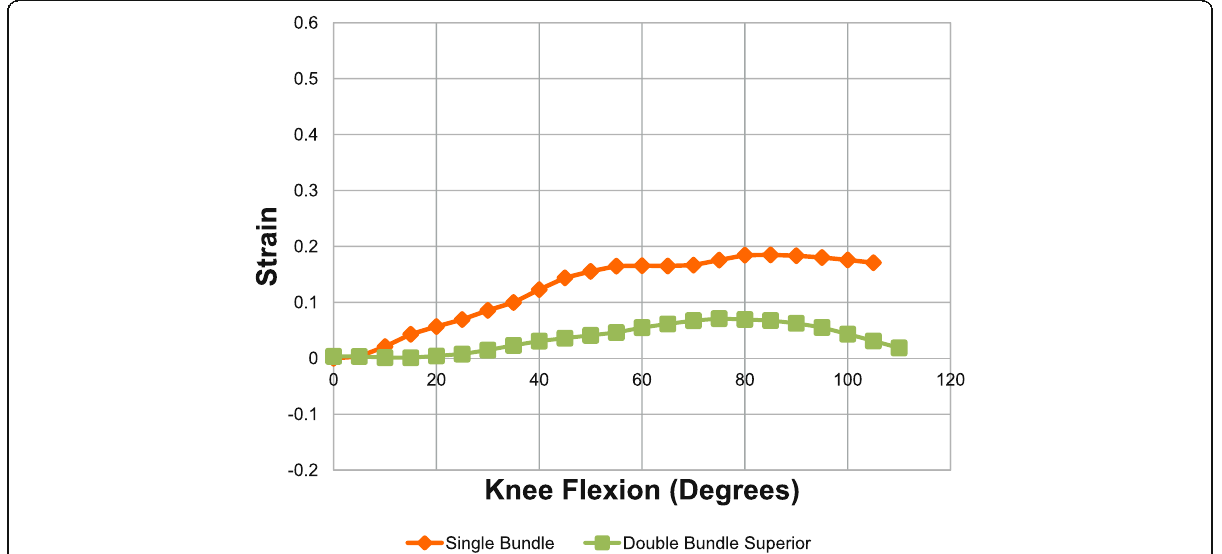
Fig. 8 Strain pattern of single-bundle and superior band of double-bundle MPFL as knee flexed from 0 to 105 degrees. Green – superior reconstructed, Orange – single bundle reconstructed